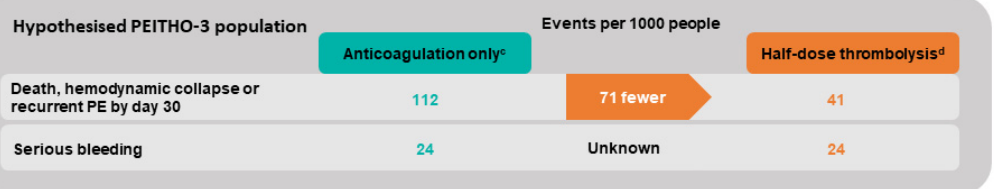
Figure 3. Extrapolated effect of half-dose thrombolysis in the hypothesized PEITHO-3 population. c Basal risk derived from applying the PEITHO-3 inclusion criteria and outcome to the PEITHO population [79]. d Relative treatment effect of full-dose thrombolysis is applied, and no increased risk of serious bleeding is assumed, according to a meta-analysis on half-dose thrombolysis [73].